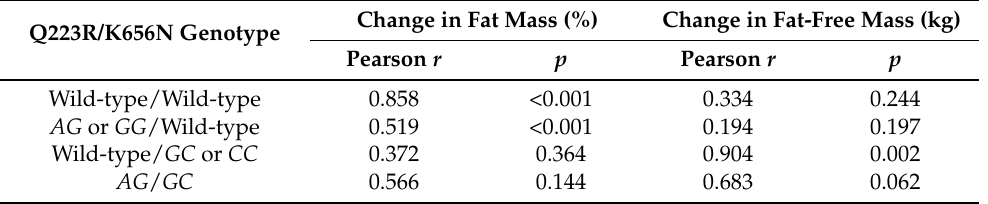
Table 6. Correlations of changes in fat mass and fat-free mass with change in SDS-BMI in children with different genotypes of Q223R and K656N LEPR polymorphisms after 3 months of dietary intervention.